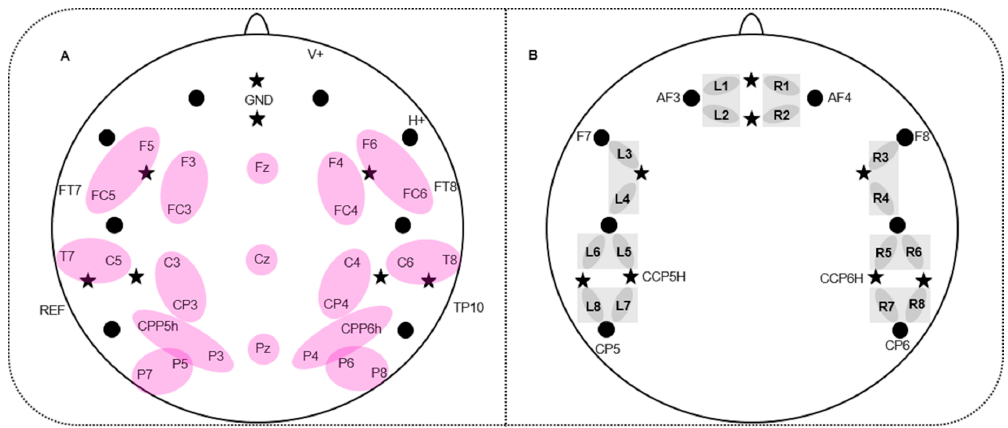
Figure 2. Simultaneous electroencephalography- (EEG)-electrodes and functional near-infrared spectroscopy- (fNIRS)-channel placement. ( A ) 32 EEG-electrodes and fNIRS probe arrangement; stars indicate 8 fNIRS light emitters; dots indicate 8 fNIRS detectors; purple ellipses indicate regions of interest (ROIs) of the EEG which entered statistical analyses. ( B ) fNIRS-channel placement: L1-8 show 8 left-hemispheric fNIRS-channels; R1-8 show 8 right-hemispheric fNIRS channels. fNIRS optodes which were positioned in a standard EEG electrode position are labeled, e.g., AF3. Grey squares